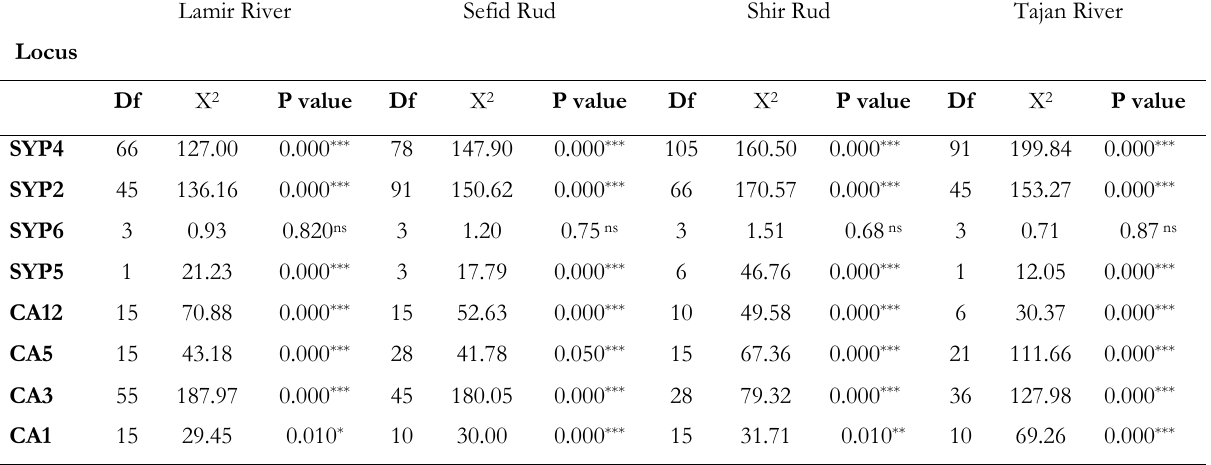
T ABLE 3. Summary of Chi-Square Tests for Hardy-Weinberg Equilibrium in different sampling